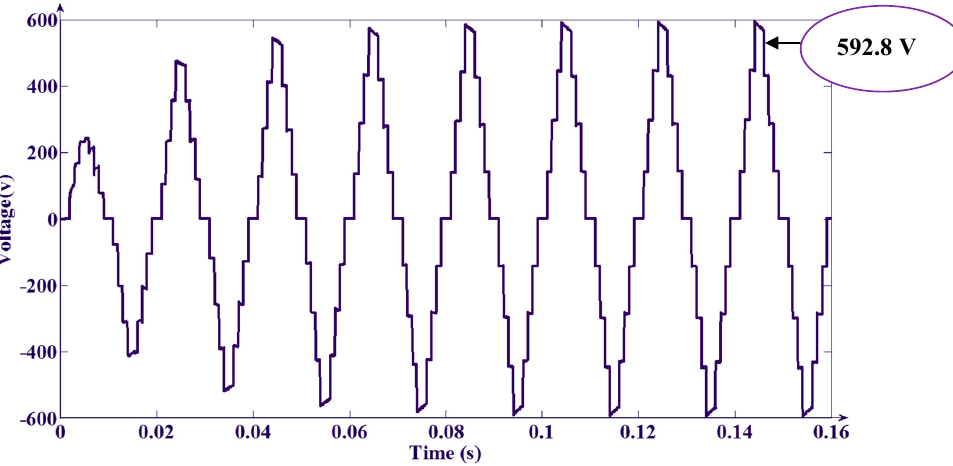
Figure 50. Output voltage ripple for hybrid controller-3-based BDC.